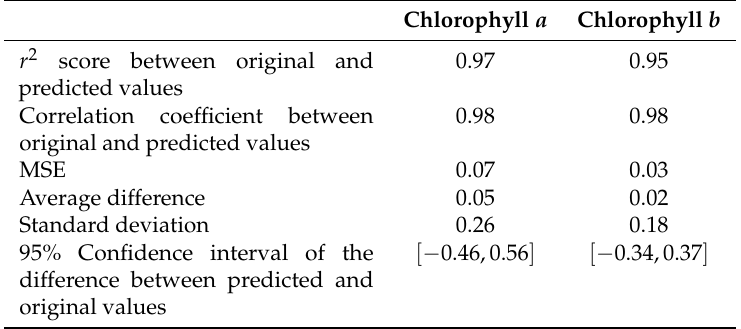
Table 4. Results of training and validating the CNN estimators for chlorophyll a and b